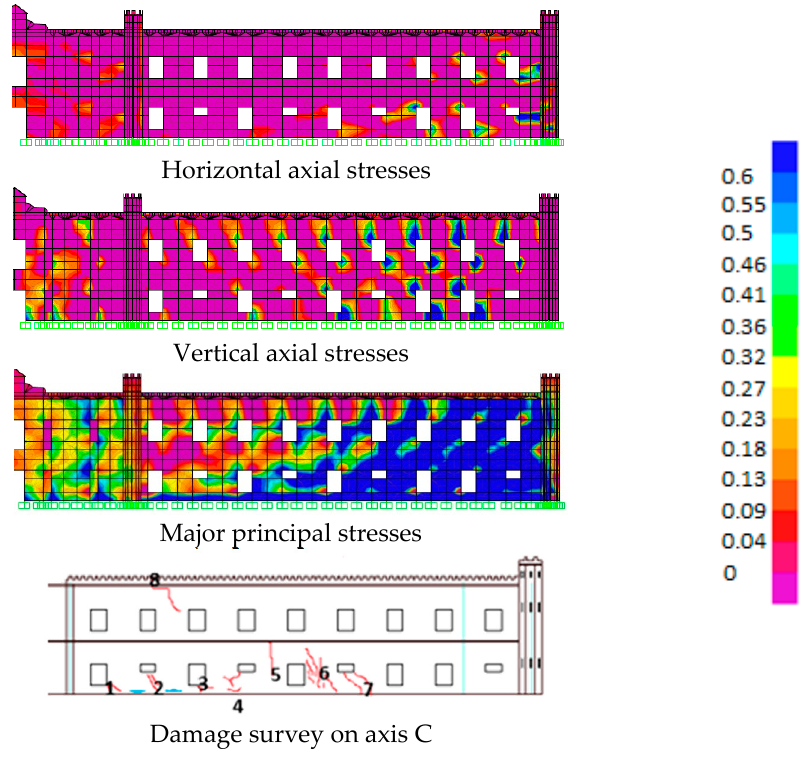
Figure 15. Comparison between stresses (MPa) at the front and existing damage. Infrastructures 2018 , 3 , x FOR PEER REVIEW